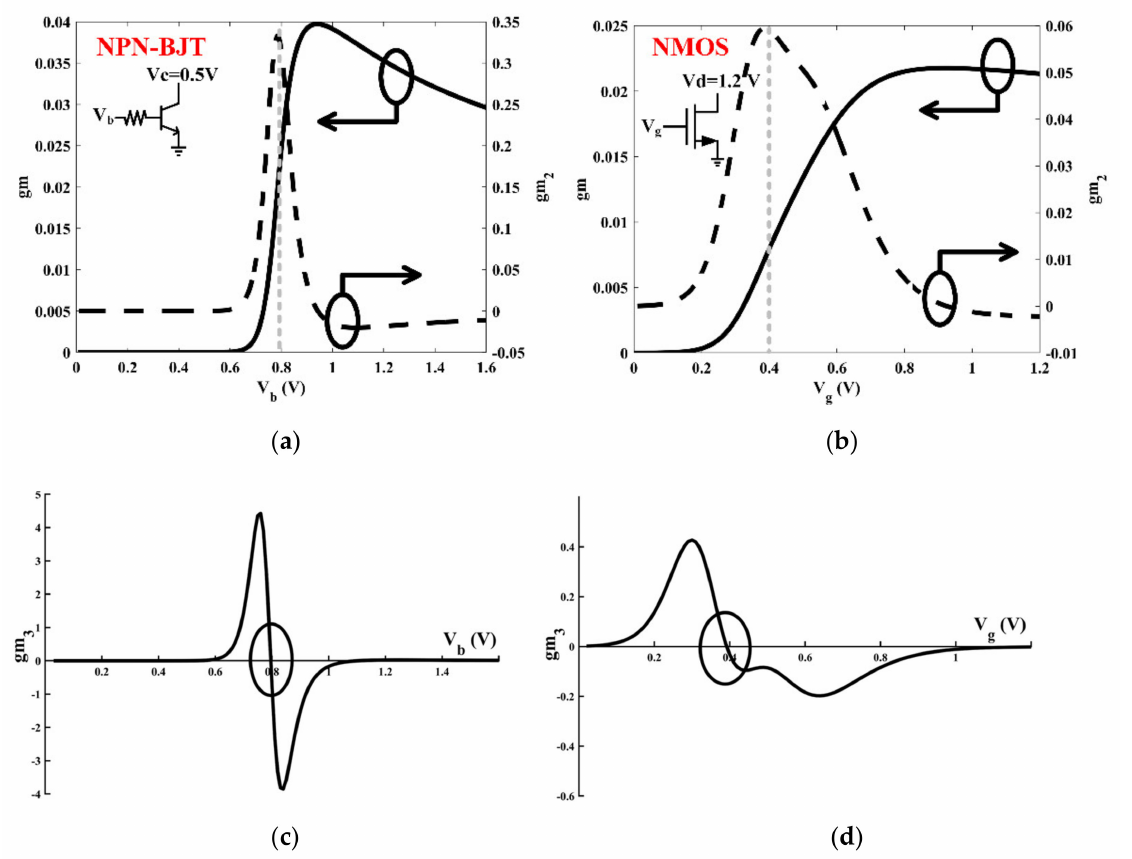
Figure 5. Simulated gm and gm 2 versus V b (V g ). ( a ) Negative–positive–negative BJT (NPN-BJT), ( b ) N-channel metal-oxide-semiconductor (NMOS) transistor. Simulated gm 3 versus V b (V g ). ( c ) NPN- BJT, ( d ) NMOS